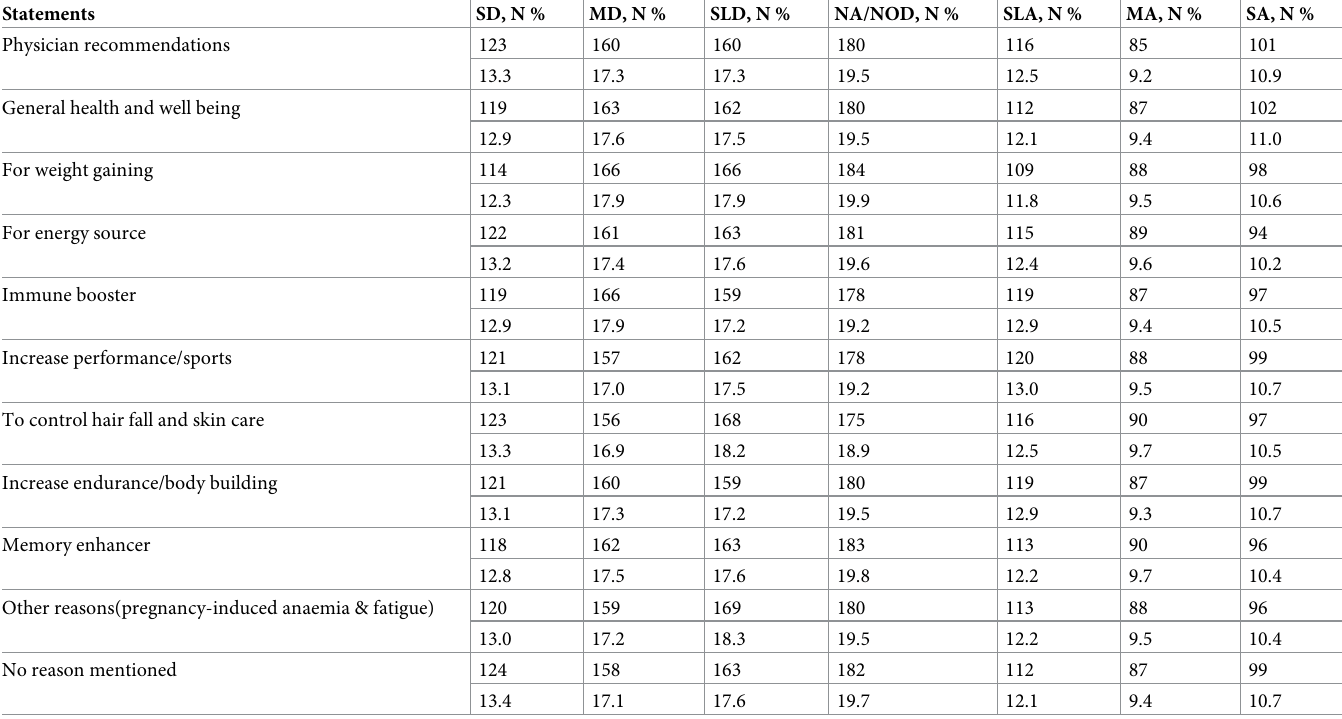
Table 3. Reasons for use of dietary